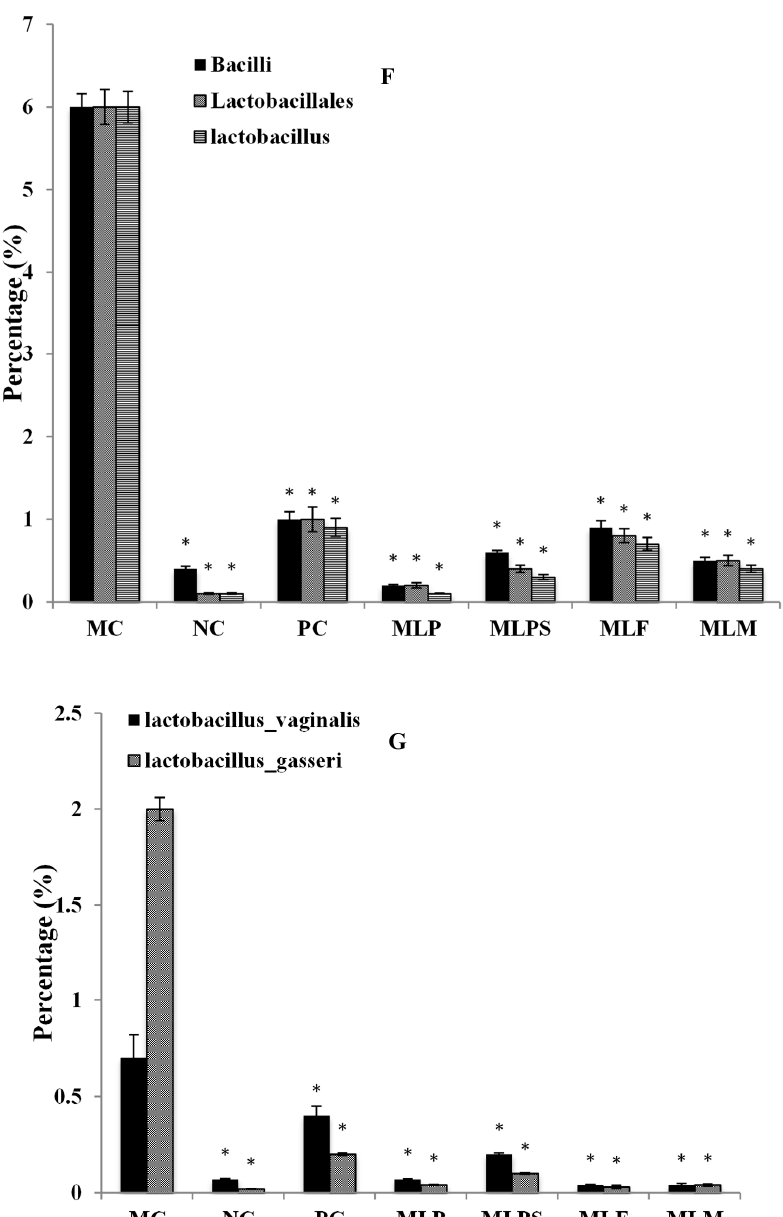
Figure 6. Mulberry leaf components change the gut microbiota composition among different groups after gavage. ( A ), Cecal microbiota at phylum level; ( B ), heap maps at species level/heat map information of the 30 most abundant species among different groups; ( C ), The Venn diagrams; ( D ), Percentage of Firmicutes and Bacteroidetes in different groups; ( E ), Clostridiales and Lachnespiraceae abundance among different groups. ( F ), Bacillus , Lactobacillales and Lactobacillus abundance among different groups; ( G ), Lactobacillus vaginalis and Lactobacillus gasseri abundance among different groups. *, p < 0.05 compared with the MC group.